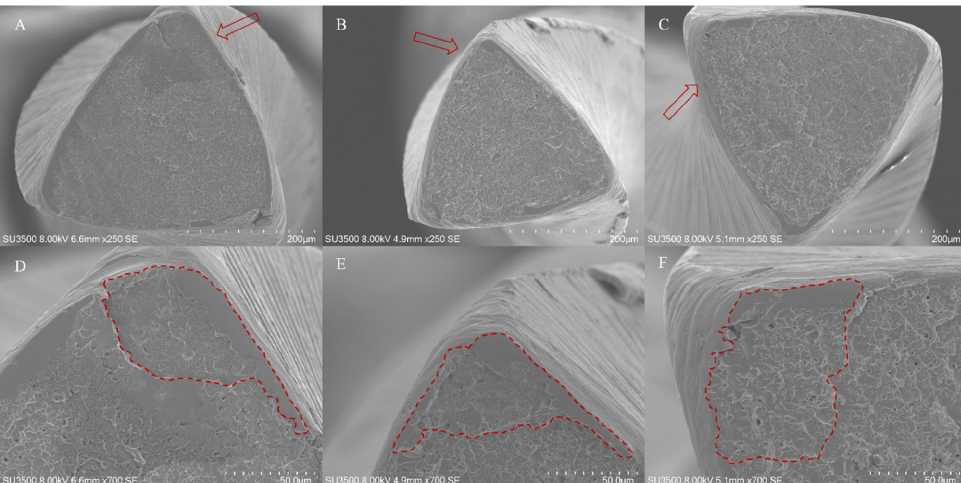
Figure 3. SEM micrographs of the fractured instruments after cyclic fatigue tests. The typical fractographic pattern arising from cyclic fatigue can observed in the micrographs (upper line, ×250 magnification): external origin of the cracks (red arrows) and a homogenous dimple area extended to the entire fractured surface. All SEM acquisition specifications are evidenced in each image. As shown in the images on the top (×250 magnification), all instruments are characterized by a triangular cross-section. Upper line images: panoramic view of the fractured surfaces, ( A ) ZenFlex; ( B ) EdgeSequel Sapphire; ( C ) Vortex Blue. Bottom line images: particular of the upper images of the evidenced area (red arrows) in which there are shown the areas of overload fast fracture zone with the external origin of the crack arising from cyclic fatigue, ( D ) ZenFlex; ( E ) EdgeSequel Sapphire; ( F ) Vortex Blue.